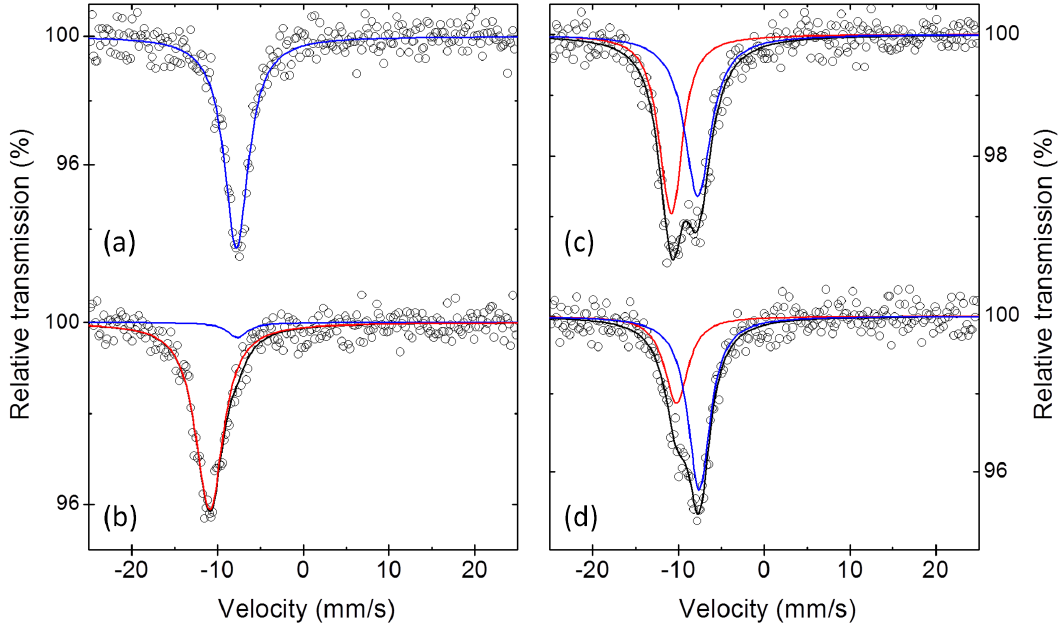
Figure 6. 121 Sb Mössbauer spectra at 78K of Sb electrodes at the end of first discharge ( a ), at the end of first charge ( b ), after the reaction of 1.5mol Na during first discharge ( c ) and after reaction of 2mol Na during the first discharge ( d